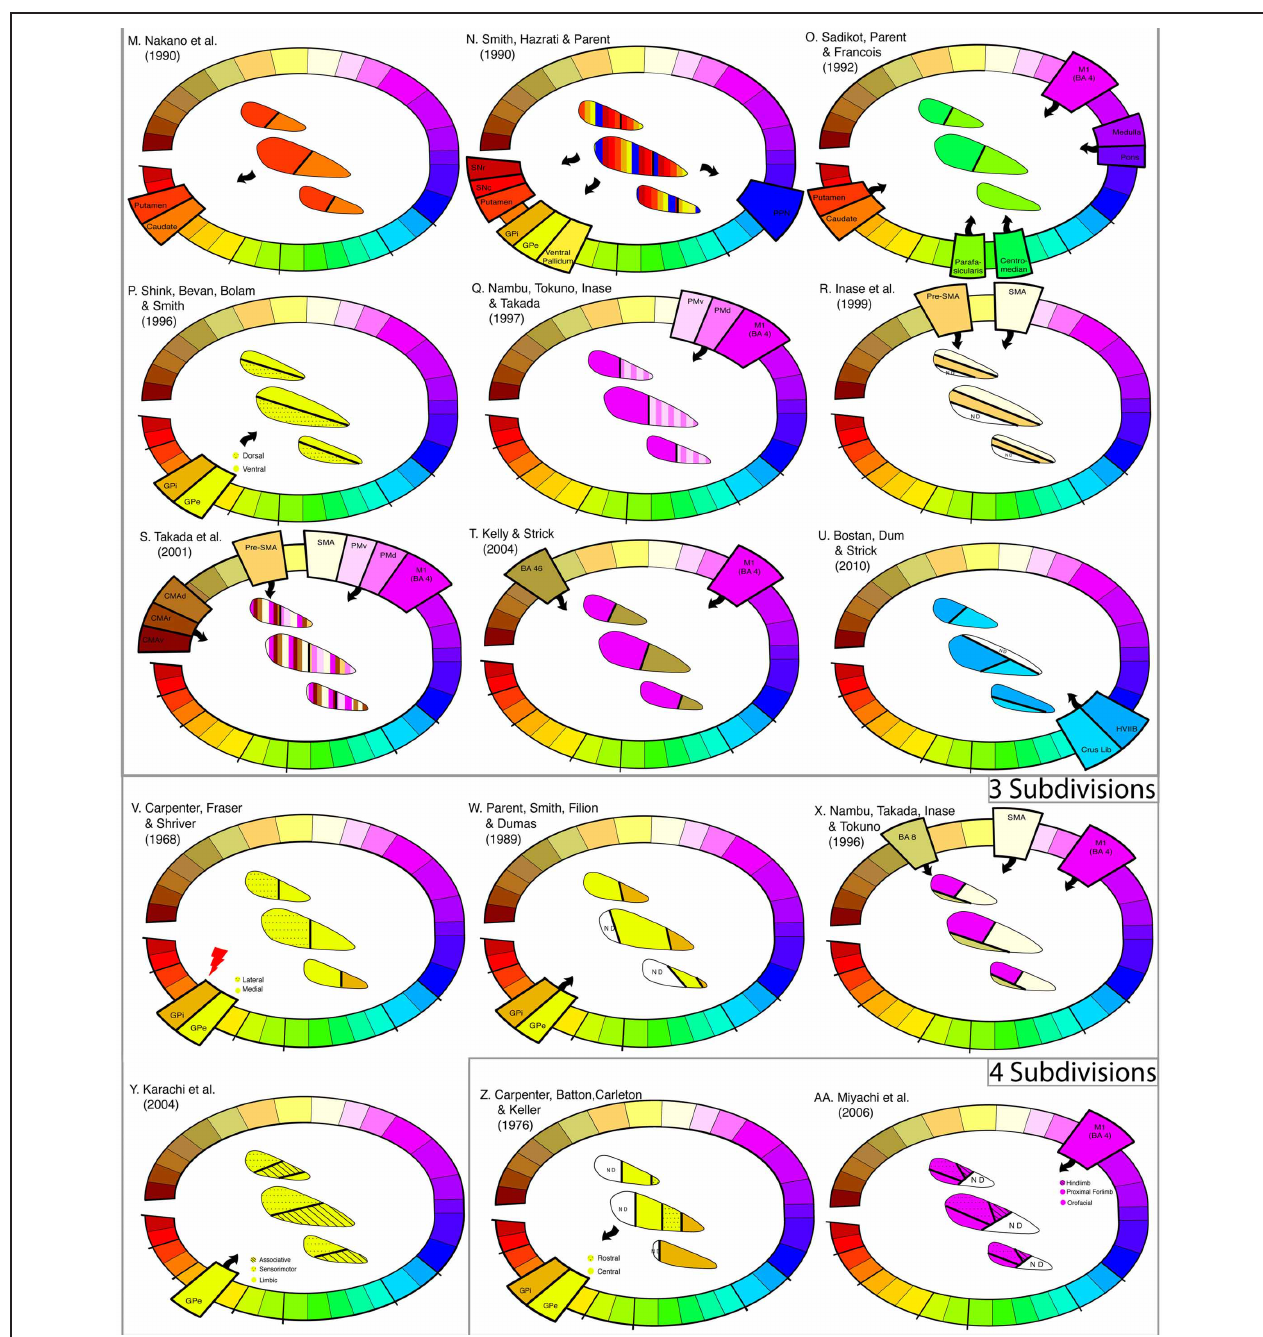
FIGURE 1 | Connection profile and subdivisions of the STN show highly variable results. ( Top of figure ) Color-coded lesion, anterograde, and retrograde tracer injection sites including cortical, subcortical, and brainstem regions. In the middle, the anatomical orientation of the STN template is displayed. Three schematic slices from caudal to rostral are shown. Anatomical abbreviations: BA, Brodmann Area; CMAd, Cingulate Motor Area dorsal; CMAr, Cingulate Motor Area rostral; CMAv, Cingulate Motor Area ventral; GPe, Globus Pallidus external segment; GPi, Globus Pallidus internal segment; HVIIB, Gracial Lobule; M1, Primary Motor cortex, PMd, Pre-Motor dorsal; PMv, Pre-Motor ventral; PPN, Pedunculopontine Nucleus; Pre-SMA, Pre-Supplementary Motor Area; S1, Primary Sensory cortex; SMA,